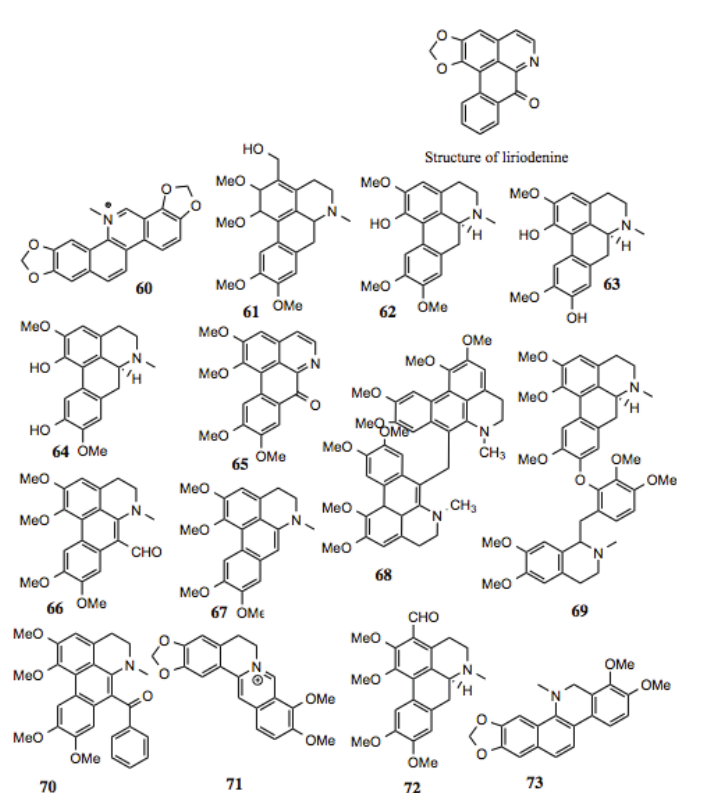
Figure 8. Benzylisoquinoline